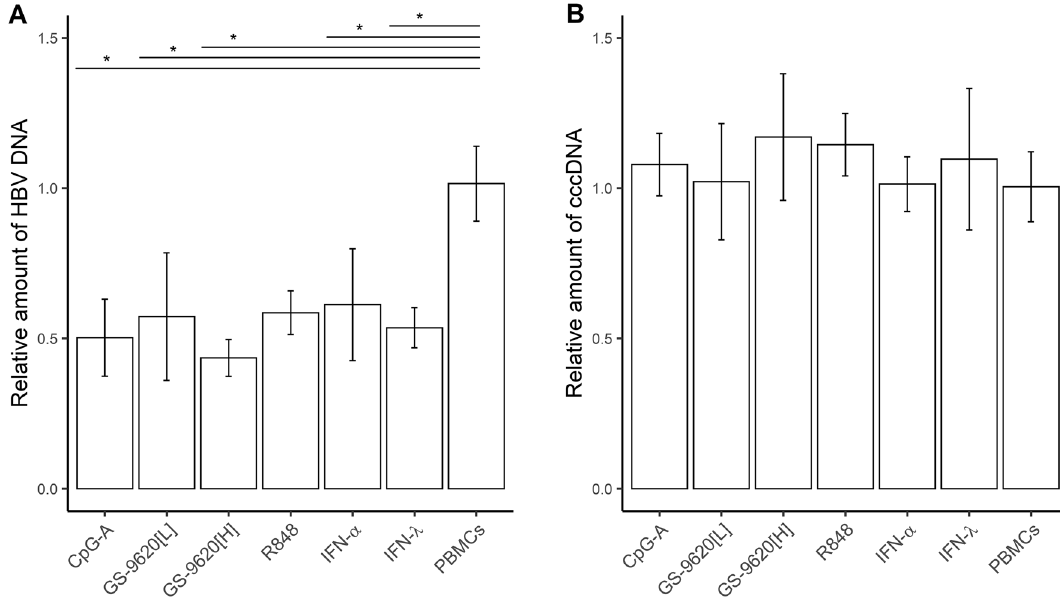
Figure 3. Reduction of total HBV DNA ( A ) but not cccDNA ( B ) in HBV-infected PHH by CM from TLR agonist-stimulated PBMCs. PHH were infected with HBV and cultured for 3 days followed by addition of CpG-A-CM, GS-9620[L]-CM, GS-9620[H]-CM or R848–CM (diluted 1:10) or 1,000 IU of IFN-α or IFN-λ. CM was added again 6 DPI. Cells were grown for 3 more days and the quantities of total HBV DNA and cccDNA were determined by qPCR. Data are shown as mean ± SEM with PHH from three donors (N = 3) for CpG- A-CM, GS-9620[L]-CM, and with PHH from one donor (N = 1) for GS-9620[H]-CM, R848-CM (two biological replicates) * p < 0.05, Dunn’s test, p value adjusted by Benjamini-Hochberg (BH) method.